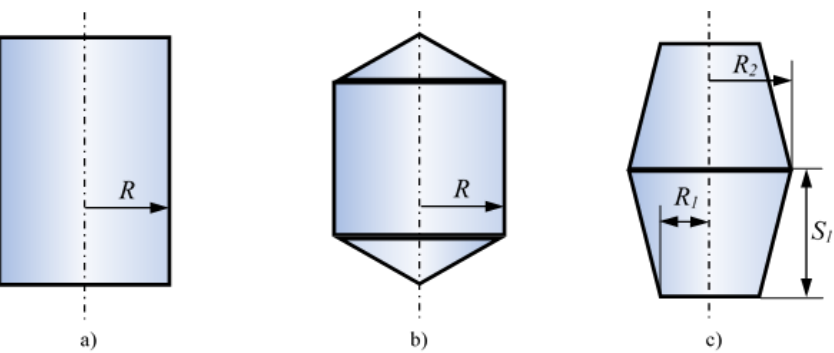
Figure 3. Different profiles of the working chambers of stage 2 of the PHPM (( a )—cylindrical; ( b )—combined, made up of cones and cylinders; ( c )—combined, made up of two truncated cones).